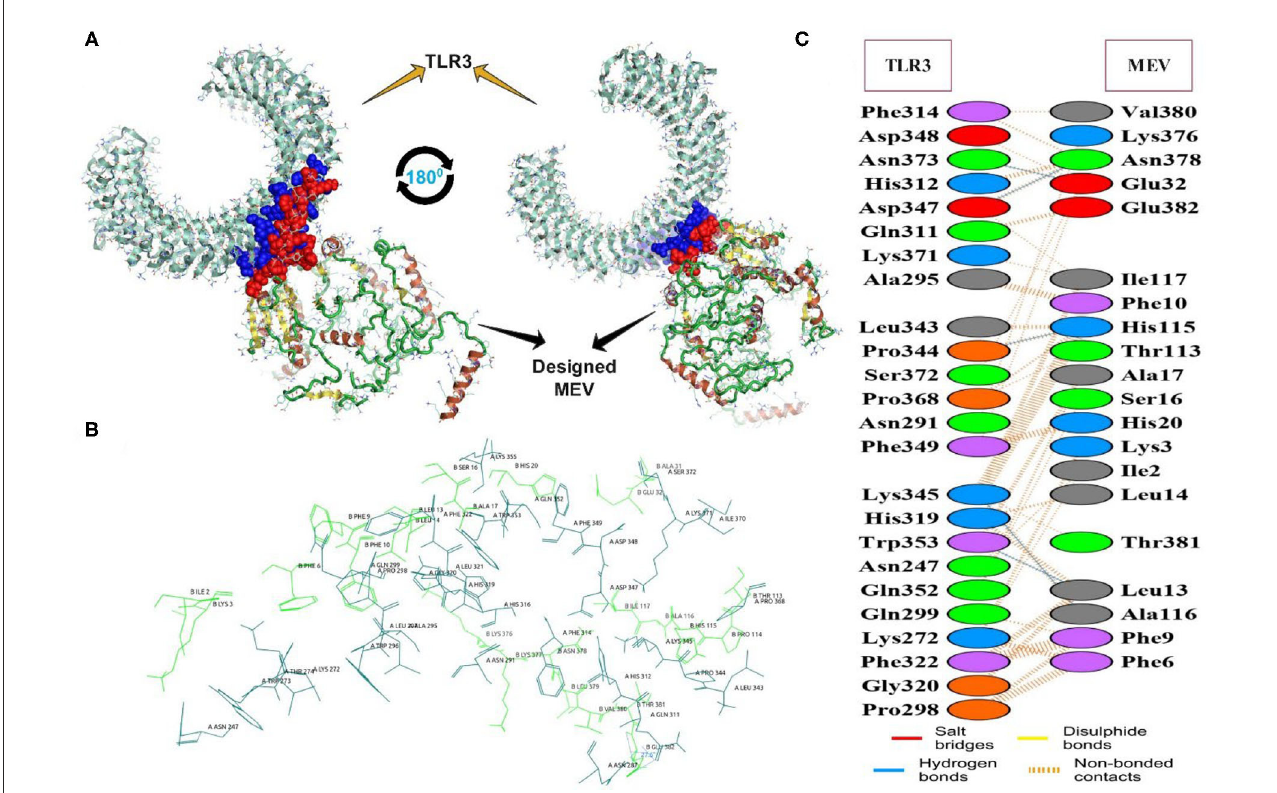
FIGURE2 The molecular interaction analysis of the designed MEV with TLR3 after protein-protein docking. (A) Interacting tertiary structure whereby interacting residues are shown by blue (TLR3) and red (MEV); (B) The interacting residues; TLR3 (Teal) and MEV (Green); (C) Different interaction between the interacting residues of TLR3 and MEV.